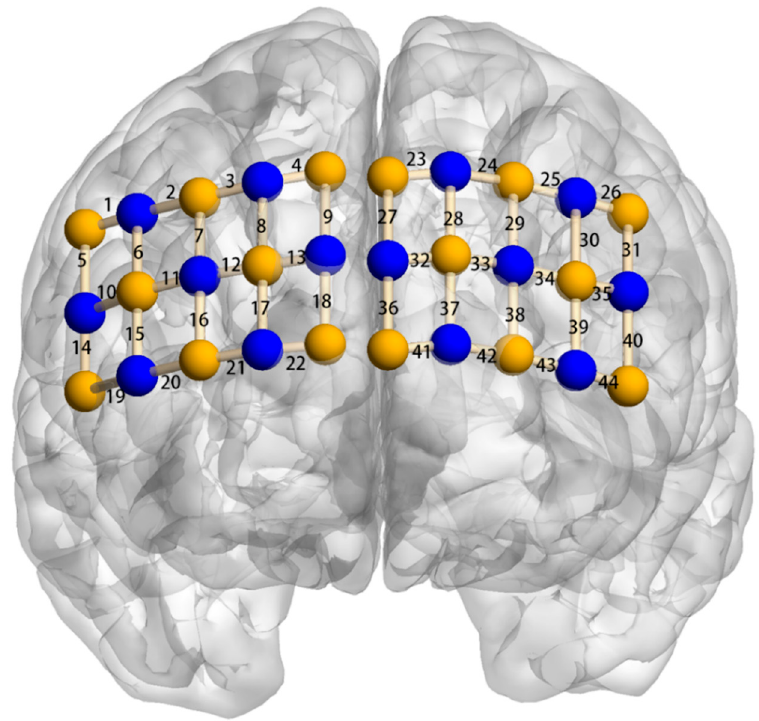
Figure 4. Localization of regions of interest. Note. Right ventrolateral prefrontal cortex (VLPFC): channel 16, 17, 21, 22; left VLPFC: channel 38, 39, 42, 43; right dorsolateral prefrontal cortex (DLPFC): channel 3, 4, 7, 8, 9, 12, 13; left DLPFC: channel 24, 25, 28, 29, 30, 33, 34; right posterior superior frontal cortex (PSFC): channel 1, 2, 5, 6; left PSFC: channel 26, 31; right temporal cortex (TC): channel 10, 11, 14, 15, 19, 20; left TC: channel 35, 40, 44; and medial prefrontal cortex (MPFC): channel 18, 23, 27, 32, 36, 37, 41.